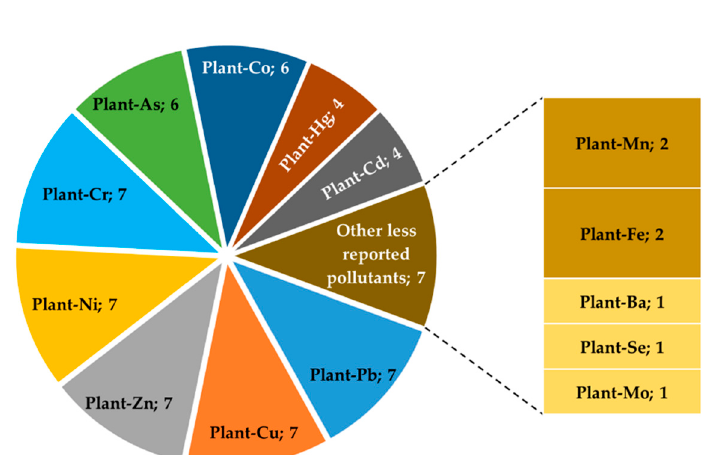
Figure A1. Biomarkers determined in non-edible plants and frequency of reporting articles ( n = 10). In total, 14 pollutants were reported. Note: As, arsenic; Ba, barium; Cd, cadmium; Co, cobalt; Cr, chromium; Cu, copper; Fe, iron; Hg, mercury; Mn, manganese; Mo, molybdenum; Ni, nickel; Pb, lead; Se, selenium; and Zn, zinc.